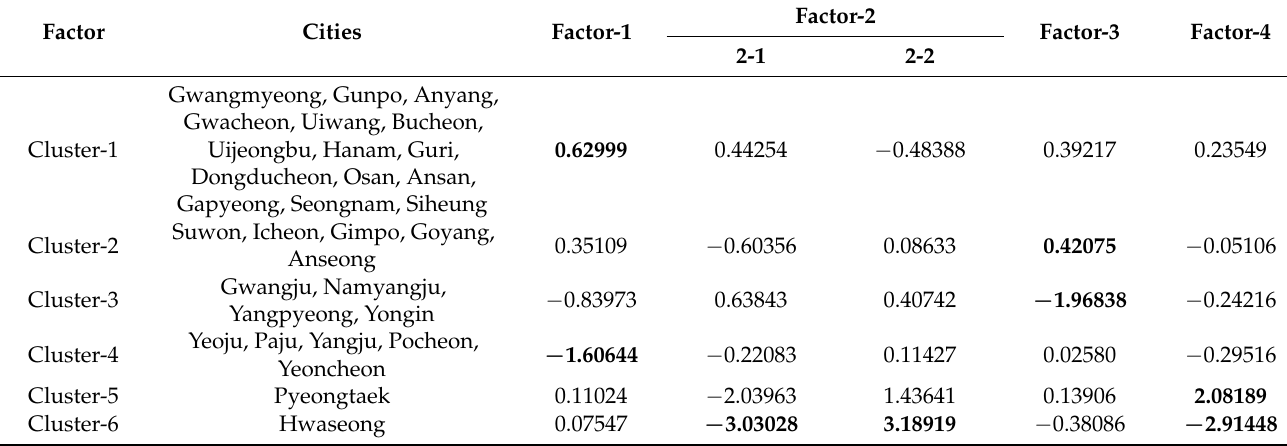
Table 5. Factor score average by cluster (the numbers in bold indicate the average value of the highest or lowest factor among the six clusters and can represent the characteristics of each